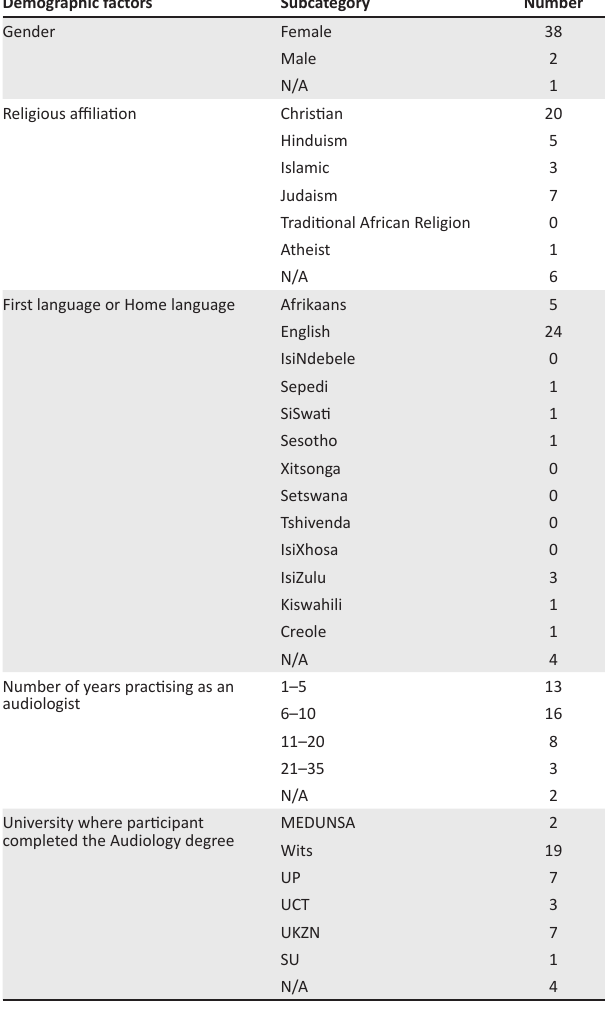
TABLE 1: Participants’ demographic